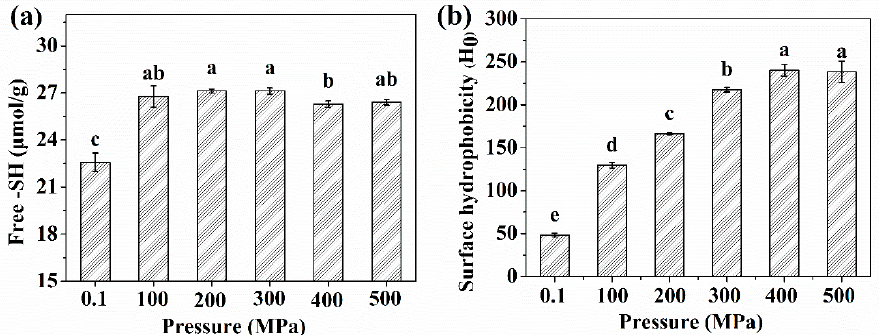
Figure 2. The content of free -SH ( a ) and surface hydrophobicity ( b ) of control and HP treated oyster proteins. Different lowercase letters indicate significant difference between groups ( p < 0.05).